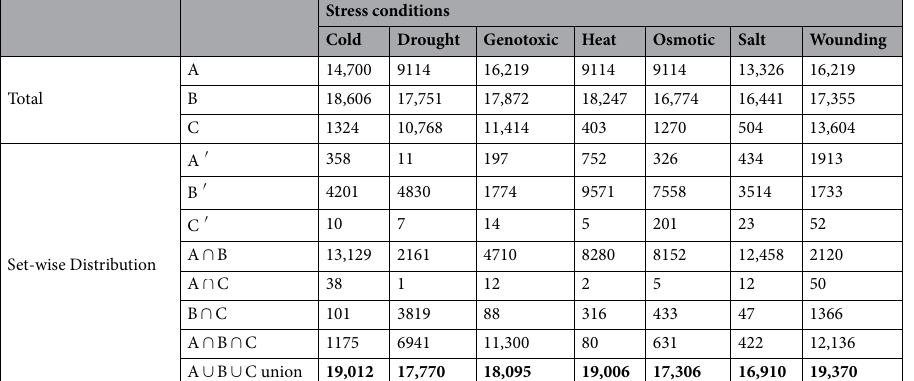
Table 2. The total number of collected genes across the experiments in stress conditions for various subunits of PP2A. Columns represents the count of unique and common genes across A, B, and C subunits. A ′ and C represent the numbers of genes which are unique in these subunits but not present in other respective subunits. Intersection ( ∩ ) and Union ( ∪ ) are shown for overlapping